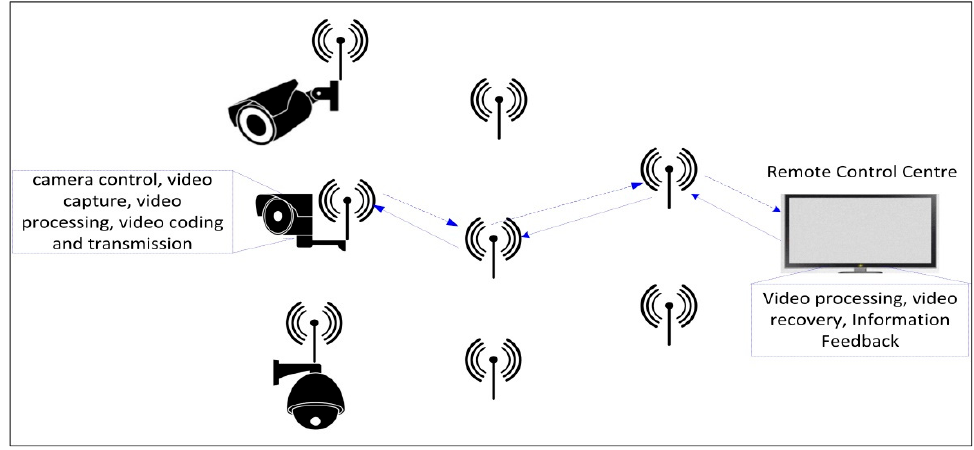
Figure 2. Overview of video surveillance system.